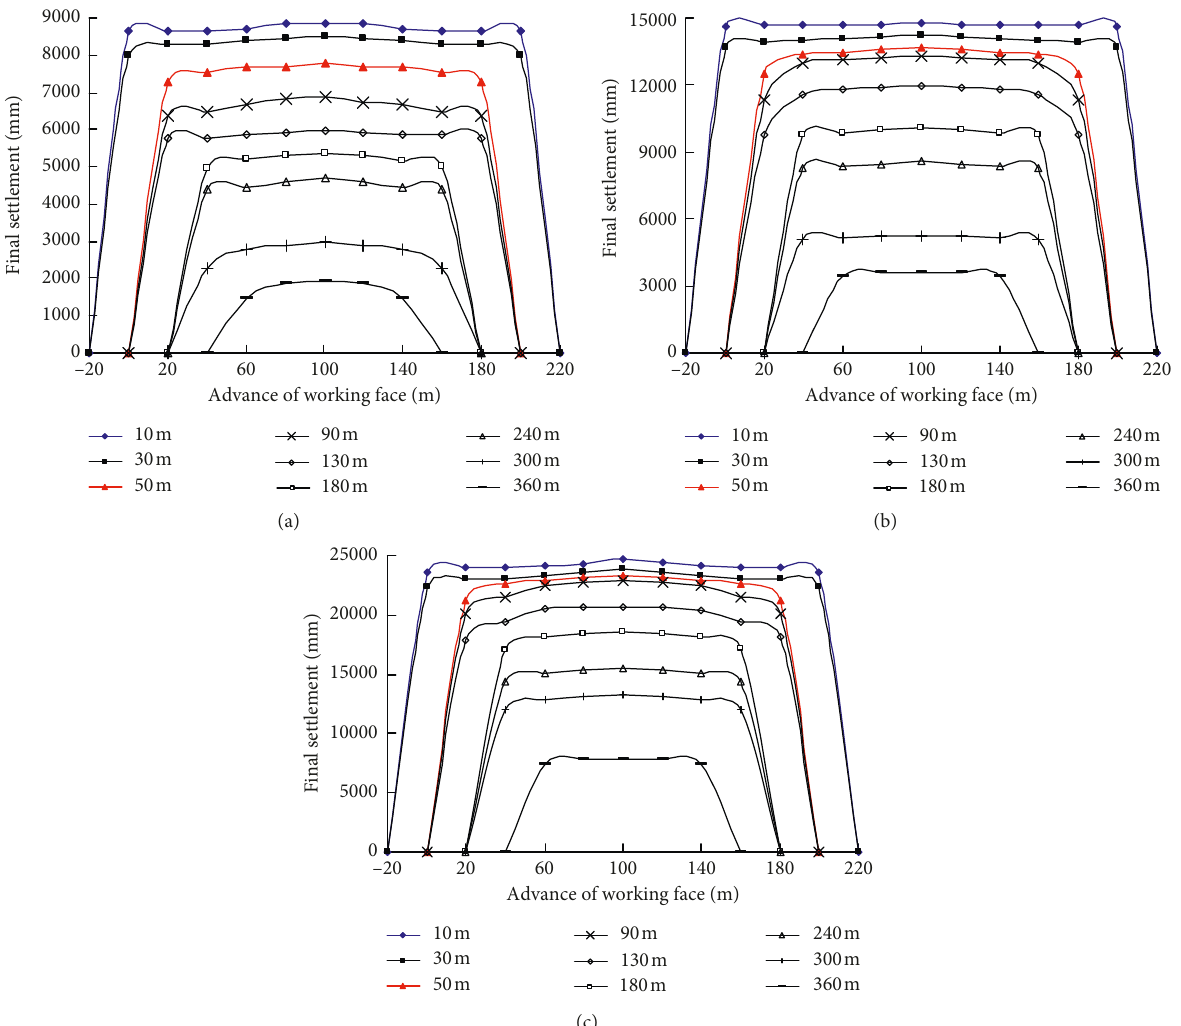
Figure 10: Curves of overlying strata movement with the advancing distance of 200m in different thick coal seams: (a) 9.0 m; (b) 15.0m; (c) 25m.